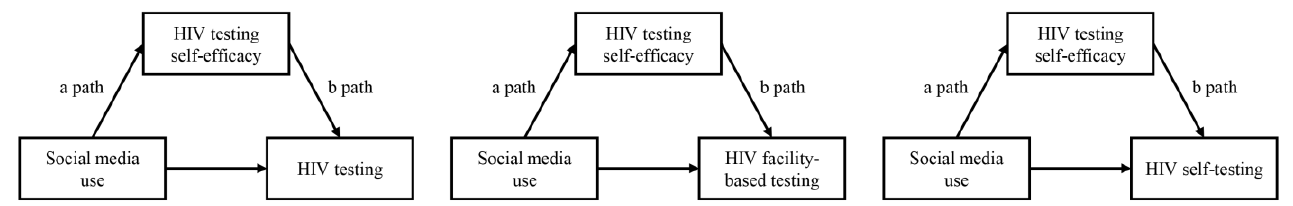
Table 4. Factors related to HIV testing in their lifetime among MSM.